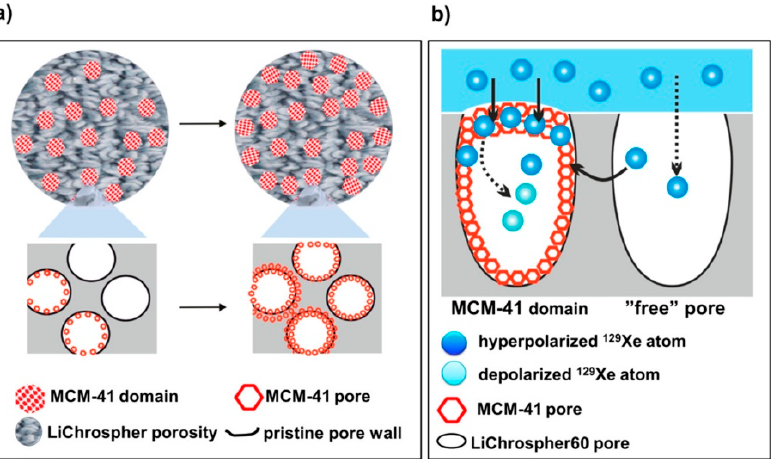
Figure 9. ( a ) Schematic representation of the transformation of LiChrospher 60 into MCM ‐ 41. ( b ) Schematic representation of the transport of 129 Xe in the partially transformed material. Reprinted with permission from reference [105]. Copyright 2017 American Chemical Society.